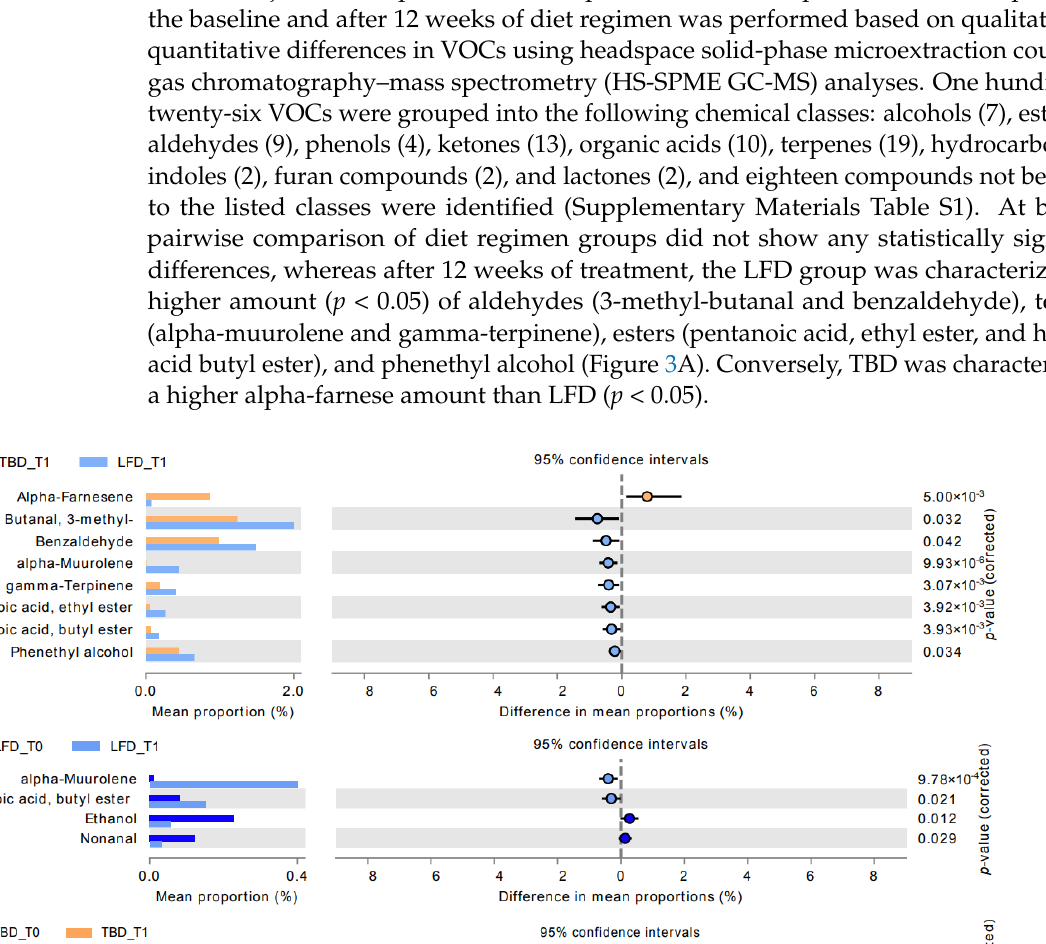
Figure 4. Spearman R-correlation coefficient of top 25 VOCs with IBS-SSS total score in patients administered with TBD ( A ) and LFD ( B ). Positive correlation values are shown in pink, while